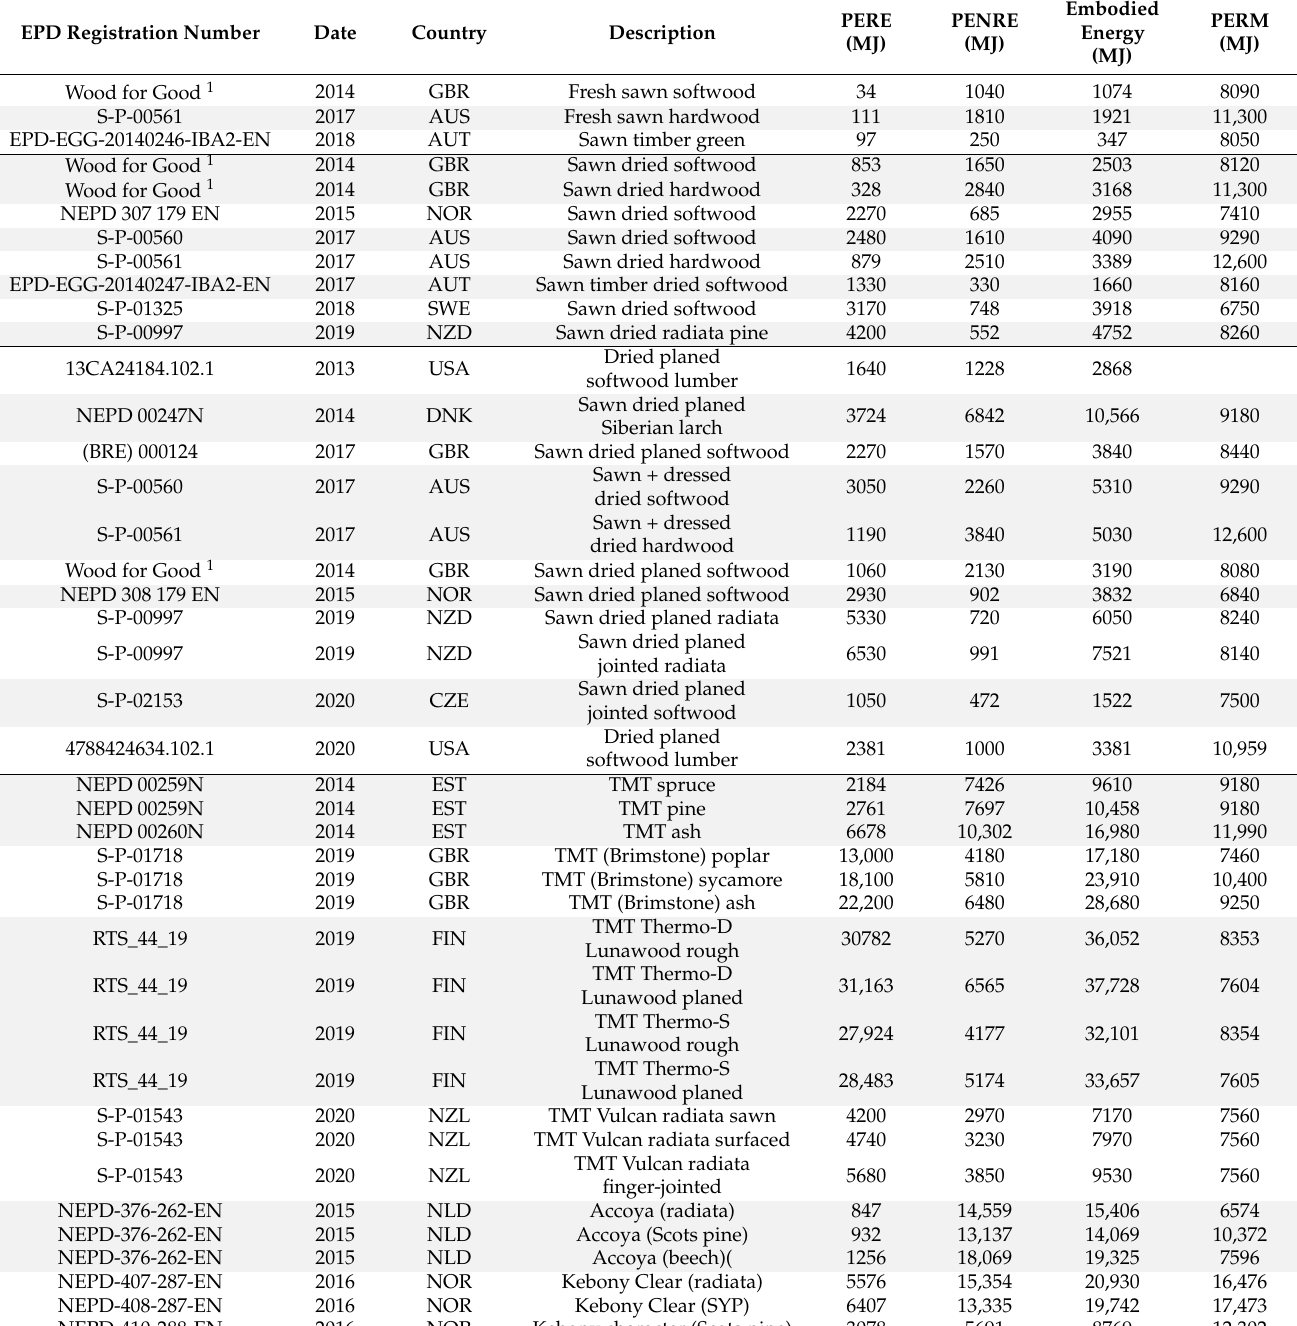
Table 3. Embodied energy and inherent energy data for modules A1–A3 (forest to factory gate) (declared unit 1 m 3 ). Abbreviations: PERE (primary energy renewable energy), PENRE (primary energy non-renewable energy), PERM (primary renewable energy in the